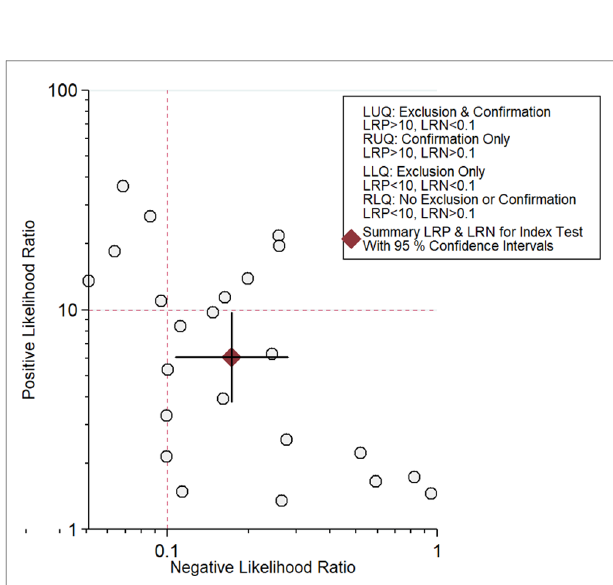
FIGURE 5 | Likelihood scattergram for PET/CT.